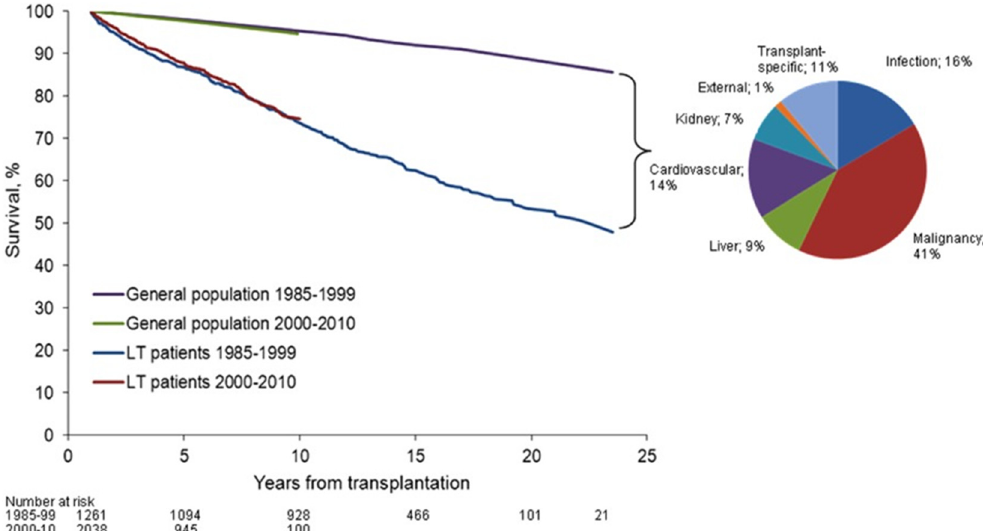
Figure 1. Patient survival rate after liver transplantation compared to general population (from Åberg et al. [3]). Overall patient survival rate beyond the first year post-liver transplantation has not been improved from the 1980s to the 2000s. Pie chart describes the distribution of cause-specific excess mortality among liver transplantation recipients. Elevated standardized mortality rates in liver transplantation patients were evident for infection, malignancy, liver disease, and kidney disease, reflecting the comorbidities of long-term immunosuppression therapy. Reprinted with permission from ref. [3]. Copyright 2015 Wiley. Copyright 2014 by the American Association for the Study of Liver Diseases.